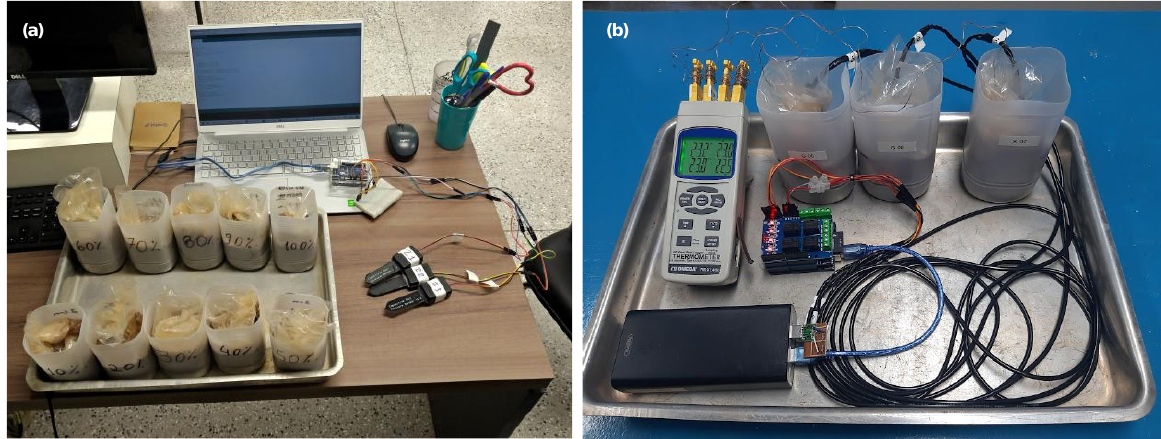
Figure 2. Lab conditions during ( a ) calibration and ( b ) temperature tests.